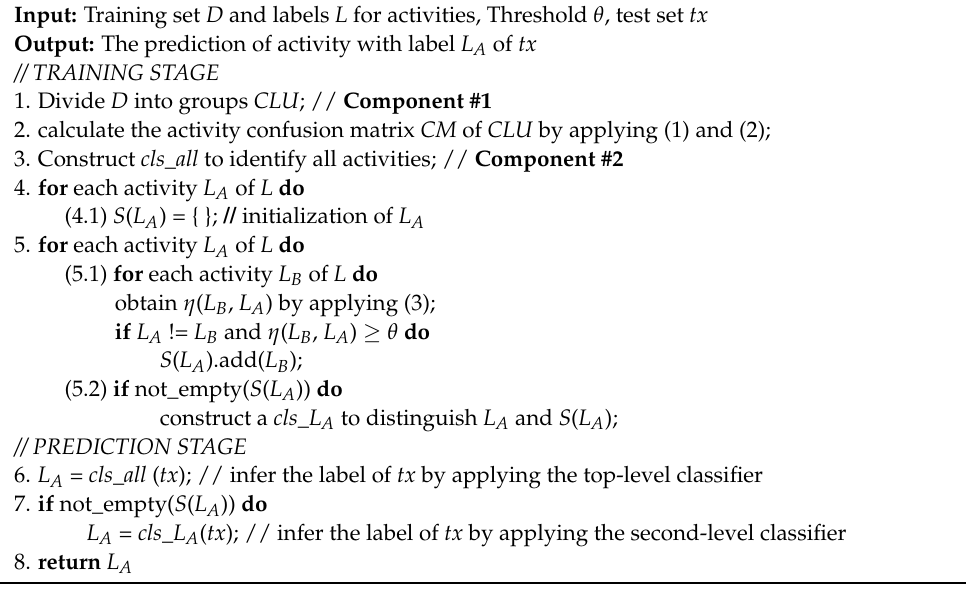
Algorithm 1: Clustering Guided Hierarchical Activity Recognition Framework.